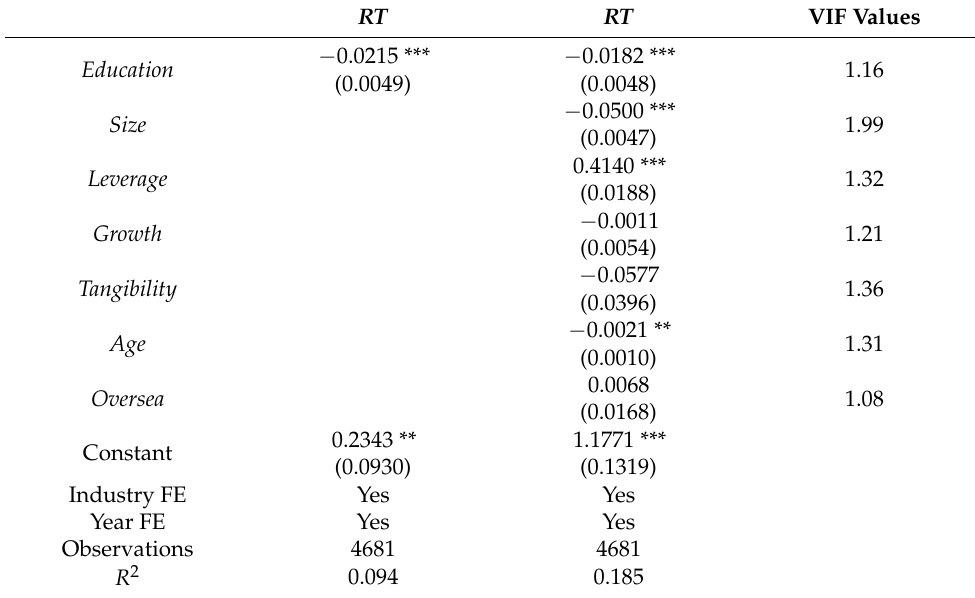
Table 3. Baseline regression results.